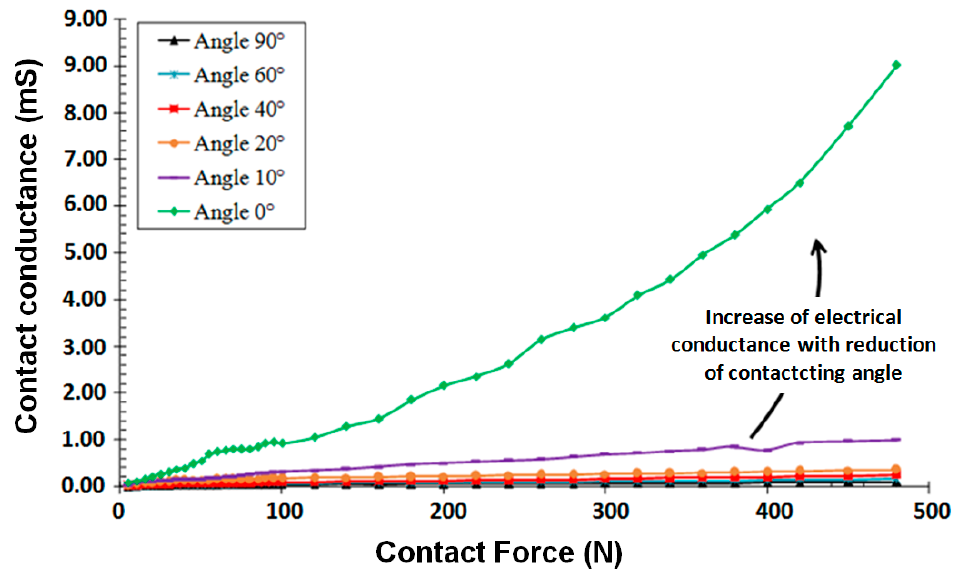
Figure 5. Variation of the electric conductance as a function of contact force to two extreme arrangements of conductors (angle 0° and